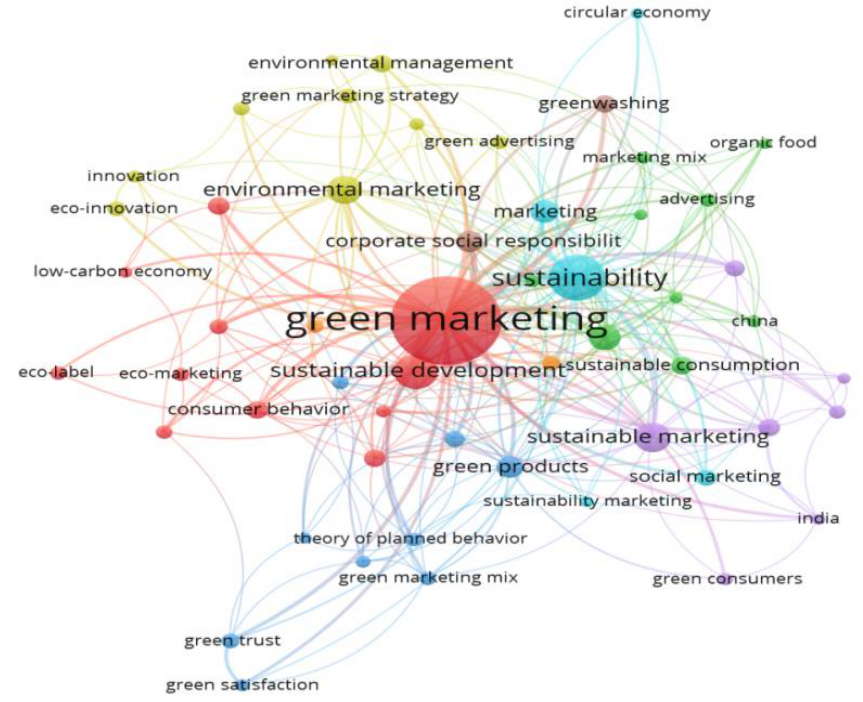
Figure 6. Co-occurrence network of author keywords (minimum number of occurrences: seven).